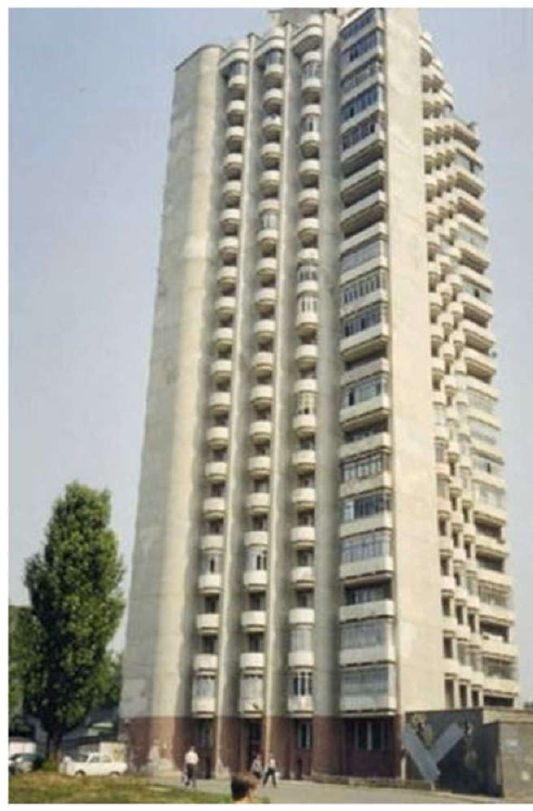
Figure 20. Residential building made using geopolymer concrete without any OPC in 1989 in Lieptsk, the Russian Federation [93].